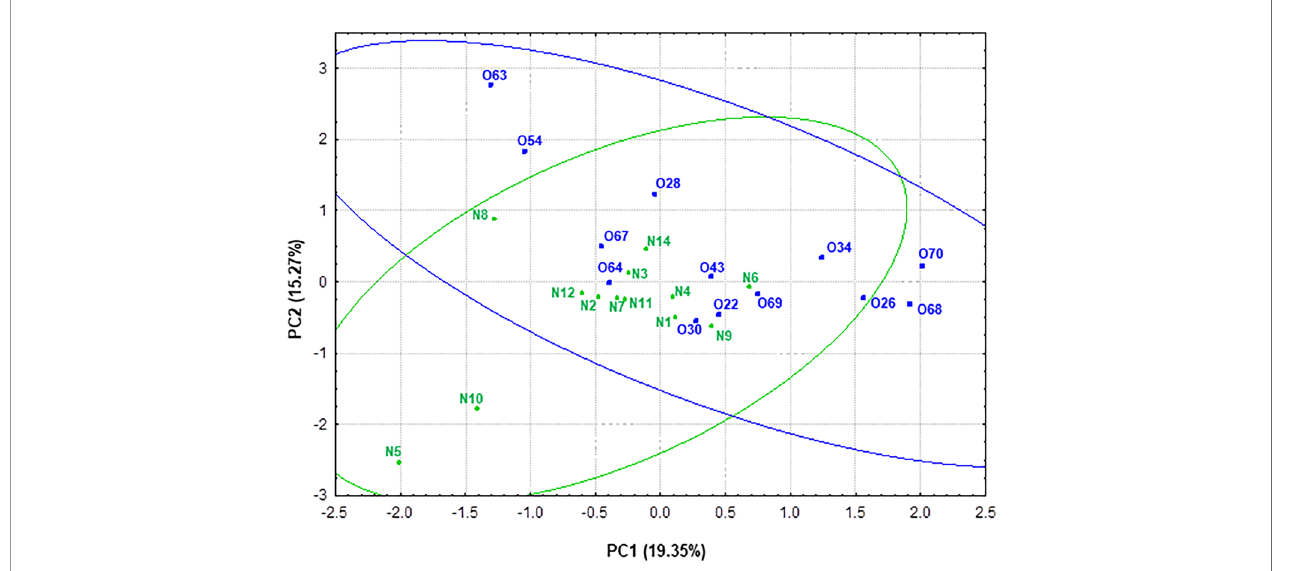
FIGURE 7 | Representation of the samples from normoweight (N) and obese (O) individuals in the plane de fi ned by the two fi rst components (PC1 and PC2) resulting from a PCA that takes into account both genera taxonomic groups and the metabolic activity — SCFAs and ammonium — data.